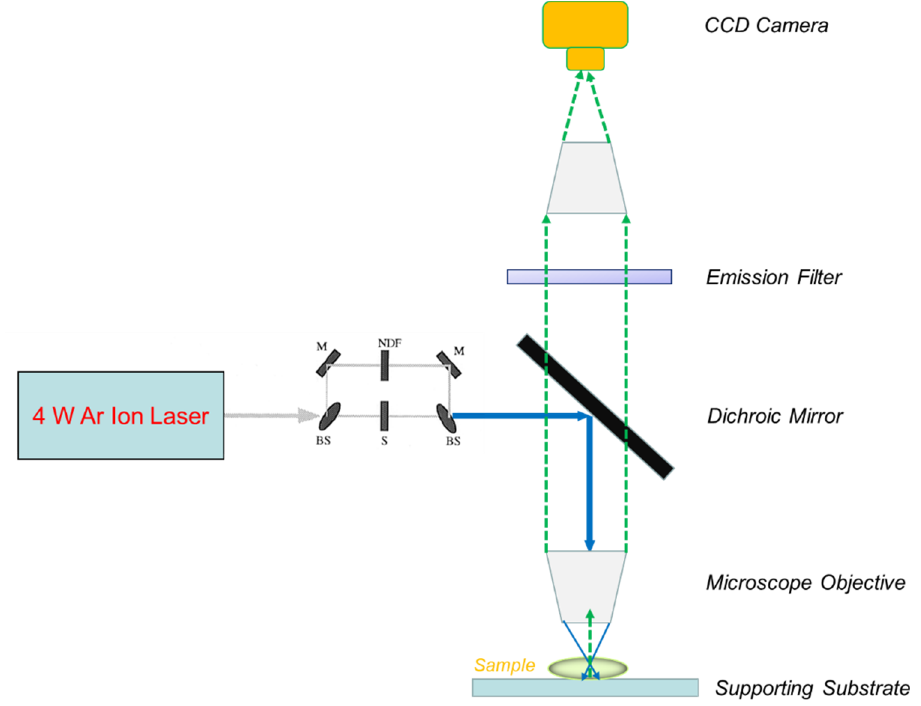
Figure 1. The general experimental setup of epifluorescence spot FRAP based on a high-power argon laser, upright microscope, and CCD camera. Beam Splitter: BS; Dichroic Mirror: DM; Mirror: M; Shutter: S; Neutral Density Filler: NDF.